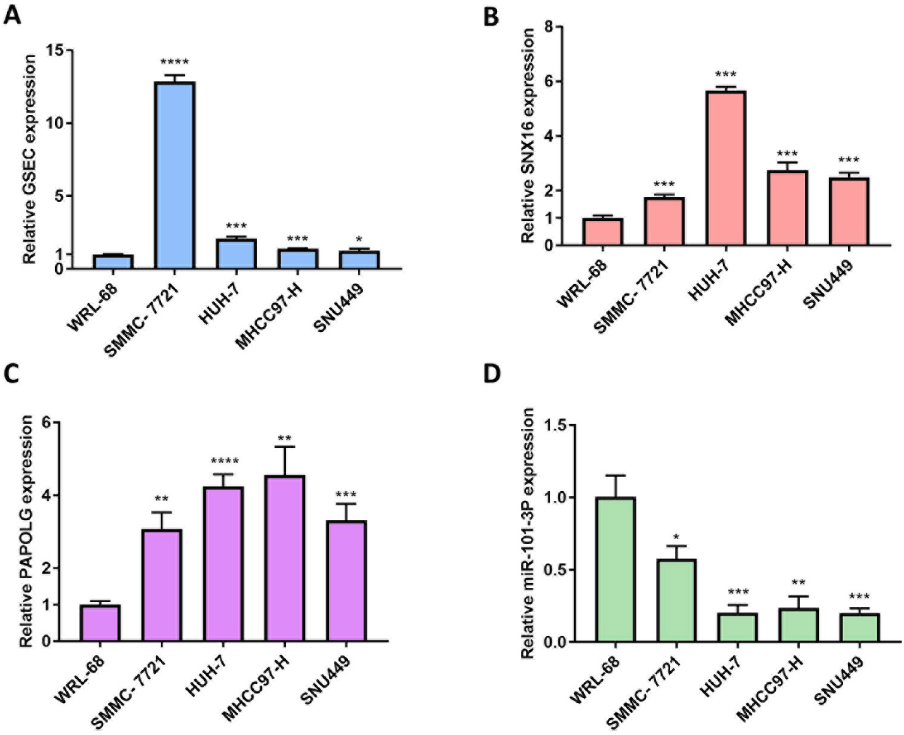
Fig 8. Relative expression of GSEC, SNX16, PAPOLG, miR-101-3p in SMMC-7721, HUH-7, MHCC97-H and SNU449 HCC cell lines and normal hepatocytes (WRL-68) cell lines. The mRNA levels of GSEC (A), SNX16 (B), PAPOLG (C), and miR-101-3p (D) in different cell lines. The experiments were performed independently for three times. P < 0.05 ( � ), P < 0.01 ( �� ), P < 0.001 ( ��� ), P < 0.0001 ( ���� ).